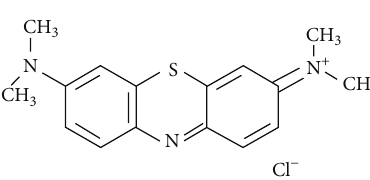
Scheme 1: Structural formula of methylene blue